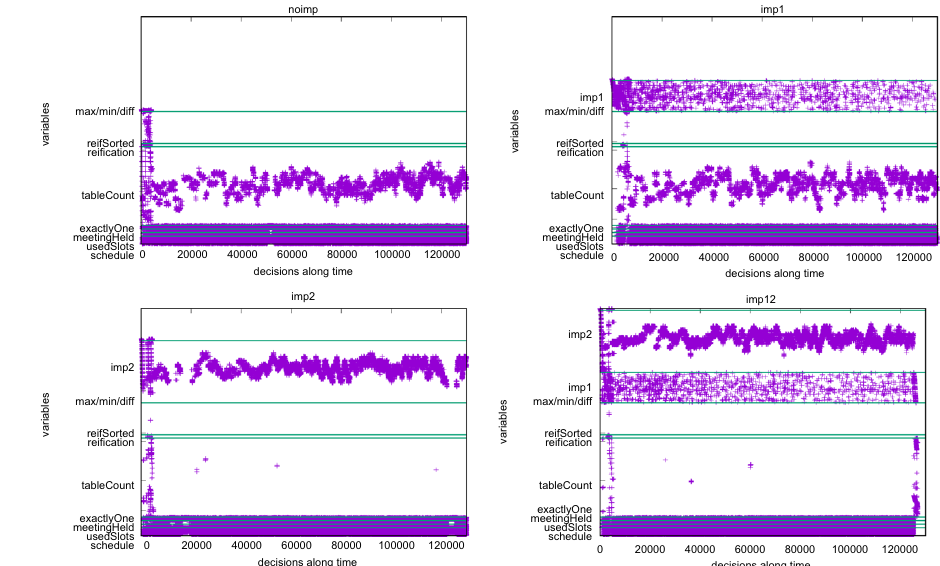
Table 2 Statistics of solving real-world B2B instances, varying the shape s , for a fixed T ⋅ L density d (with fixed)